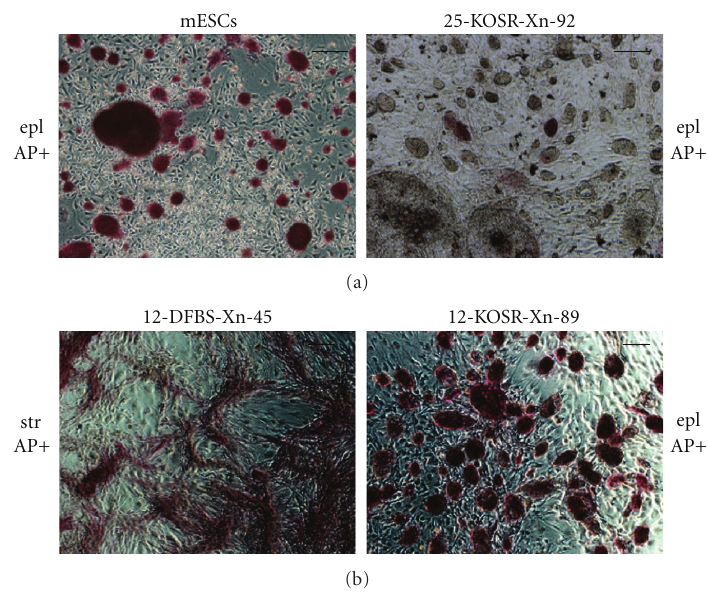
Figure 4: Evaluation of the morphology and alkaline phosphatase activity of expanded reprogrammed colonies of SACK-D strains mPanstra-12 and mPanstra-25. Shown are examples of phase micrographs of colonies developed from reprogrammed cell clones and stained for alkaline phosphatase activity. The estimated alkaline-phosphatase-positive (AP+) cell fractions for colonies with epithelial (epl) or striated (str) morphology were 100% for mESCs, 10% for 25-KOSR-Xn-92 (SACK-D strain #—derivation medium—xanthine supplementation—subclone #), 50% for 12-DFBS-Xn-45, and 90% for 12-KOSR-Xn-89. Scale bars = 100 μ